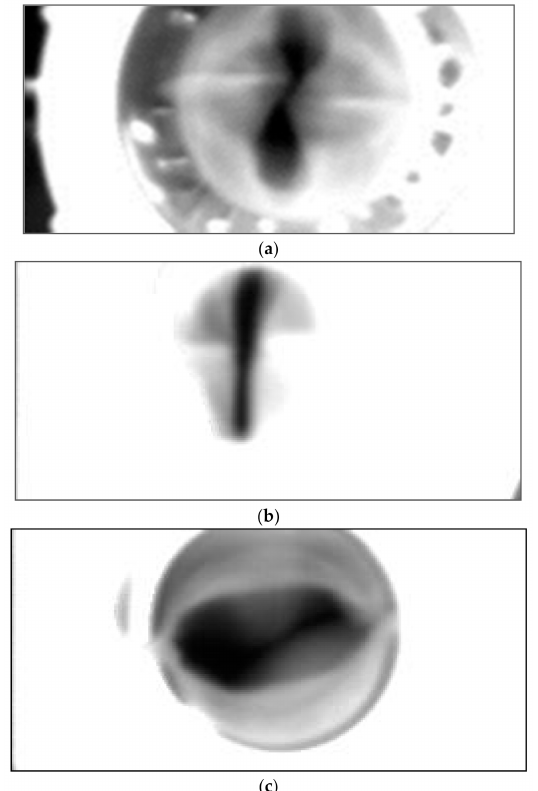
Figure 6. Greyscale recorded images of Sample 1 ( a ), Sample 2 ( b ) and Sample 3 ( c ).